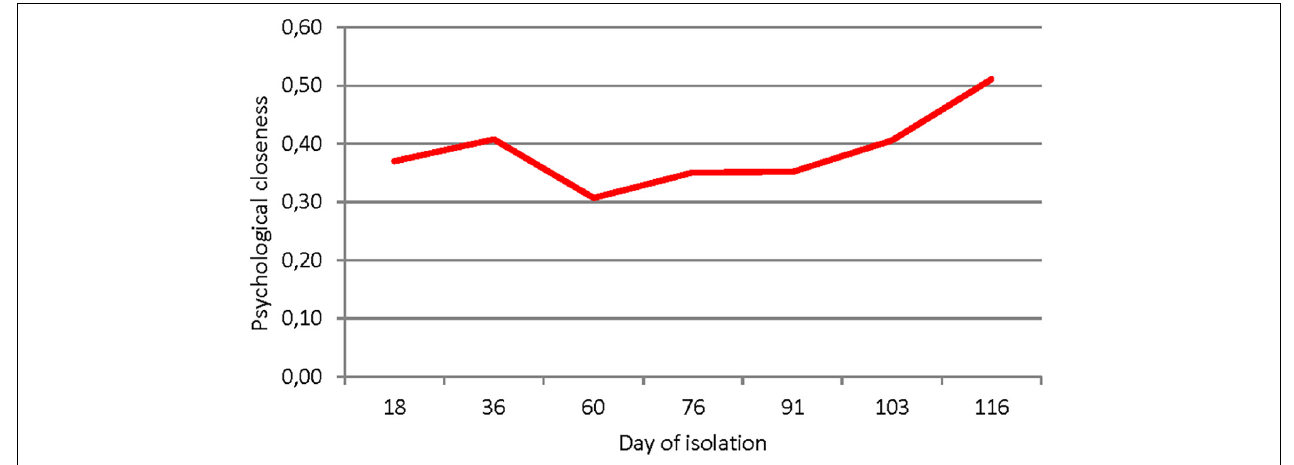
FIGURE 7 | The psychological closeness of the subjects (whole crew) in the course of isolation. TABLE 5 | Differences in use of content analysis categories between the subjects with low and average reactive anxiety levels. Categories Low level of reactive anxiety Medium level of reactive anxiety Mann–Whitney U (average values + SD) (average values + SD)